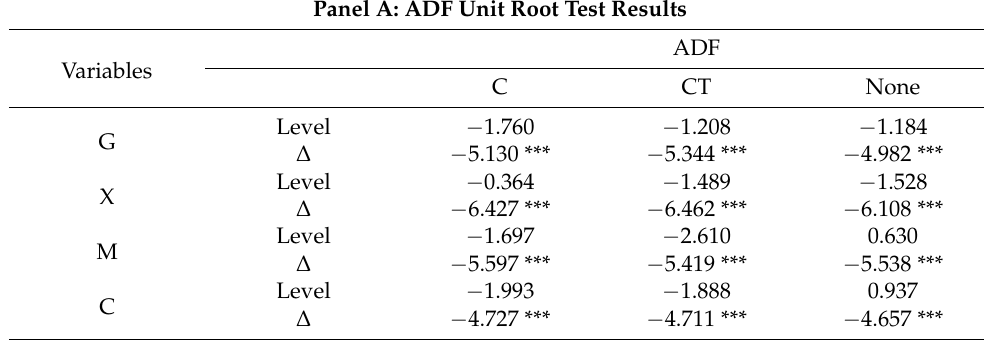
Table 1. Unit Root Test